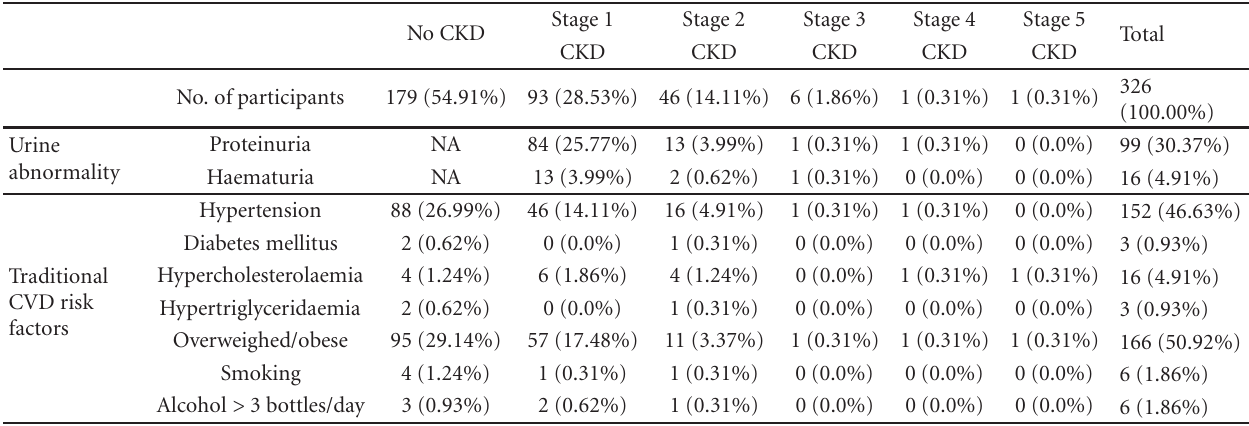
Table 2: Frequencies of participants with abnormal urinalysis and cardiovascular disease risk factors in relationship with chronic kidney disease staging.